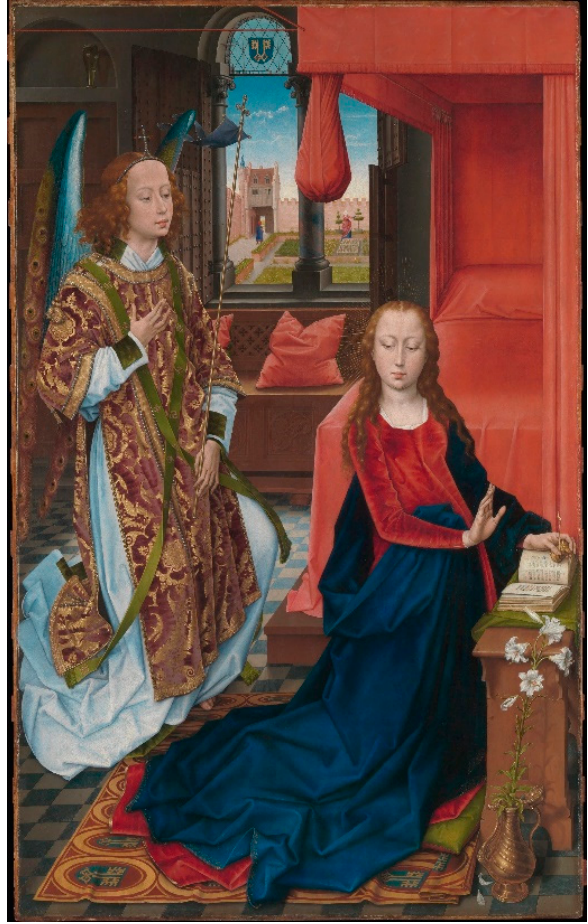
Figure 11. Hans Memling or Rogier van der Weyden’s workshop, The Clugny Annunciation , c. 1465– 1470. The Metropolitan Museum of Art, New York.